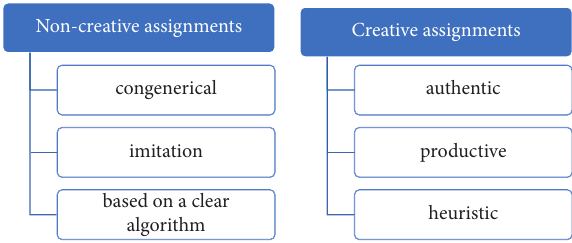
Figure 1: Differences between creative and noncreative